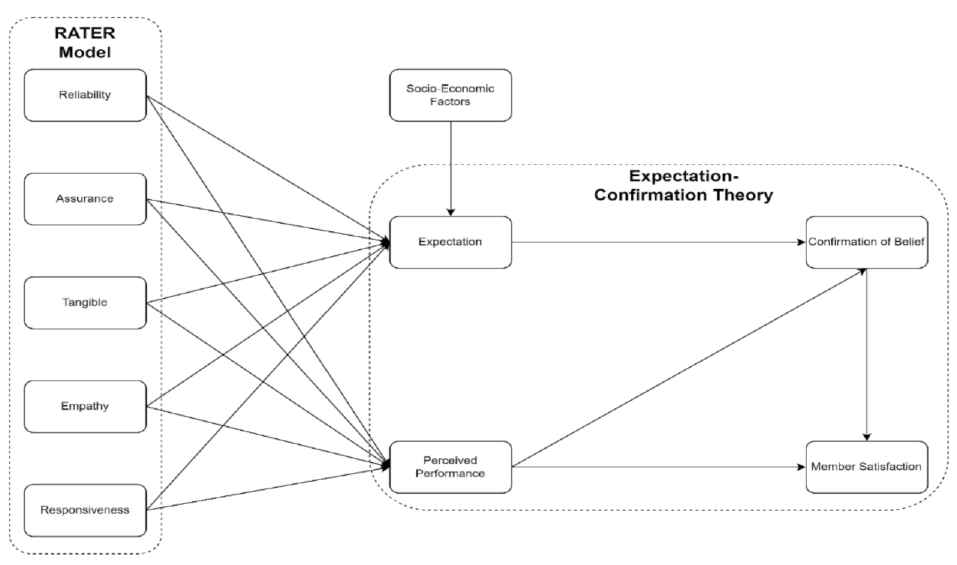
Figure 1. Conceptual